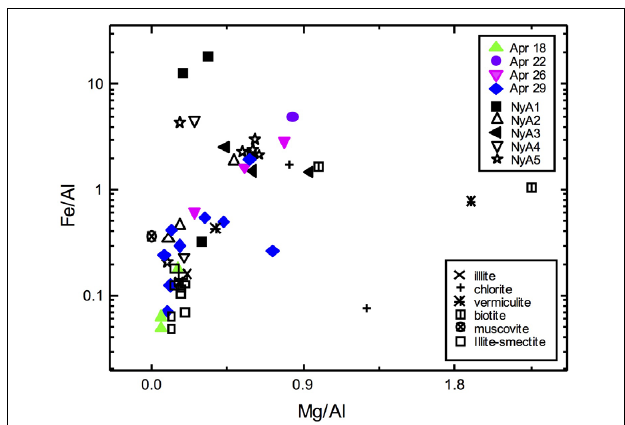
FIGURE 8 | Chemical composition by SEM-EDS microanalysis of the sheet minerals in the aerosol samples compared to the composition of NyA sediments and reference minerals.